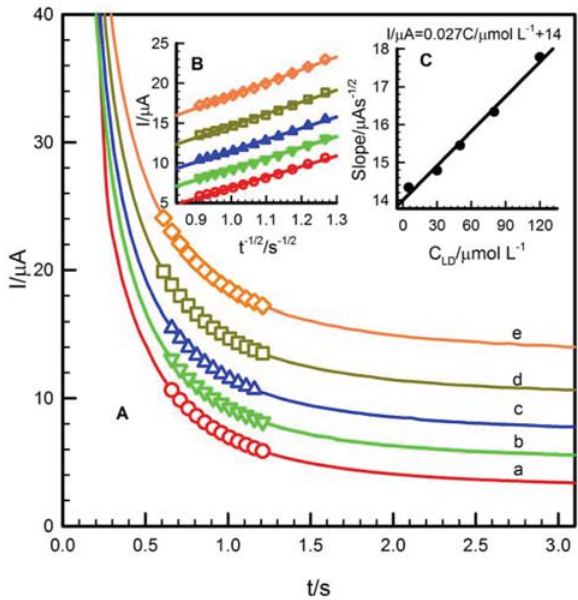
Figure 5. Chronoamperograms of (a) 5.0; (b) 30.0; (c) 50.0; (d) 80.0; (e) 120.0 μmol L –1 of LD in PBS (0.11 mol L –1 , pH 3.0) obtai- ned on PDB/MWCNTs-GCE, at the initial potential of 0.0 V and step potential of 0.5 V vs. Ag/AgCl (KCl 3 mol L –1 ) (A). The inset shows I as a function of t –1/2 (B). The inset shows the slope of lines B as a function of the concentrations of LD (C).